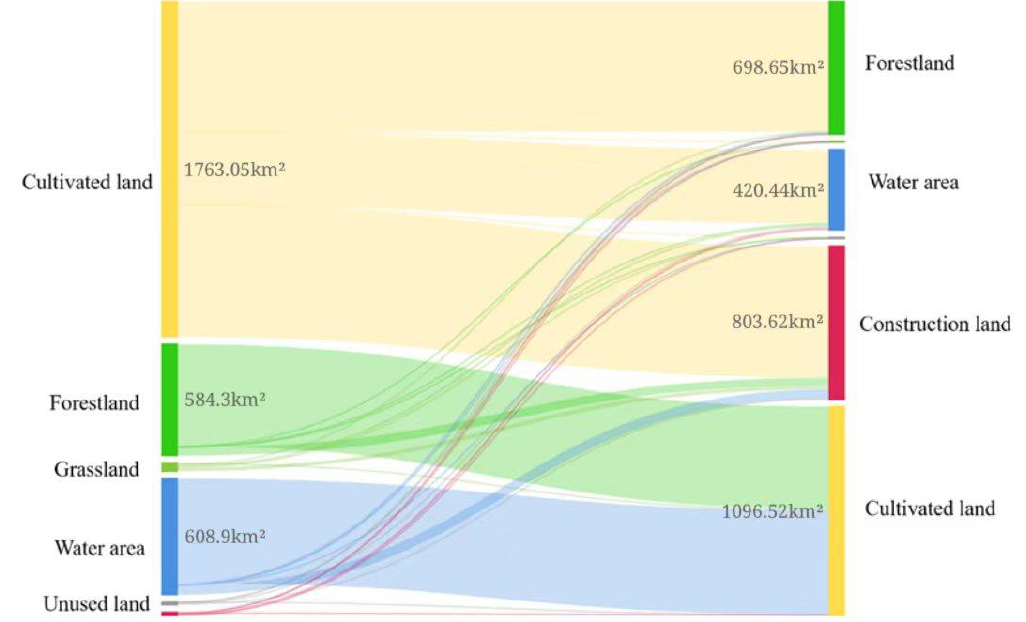
Figure 6. Sankey map of the land use transfer matrix from 1990 to 2020.